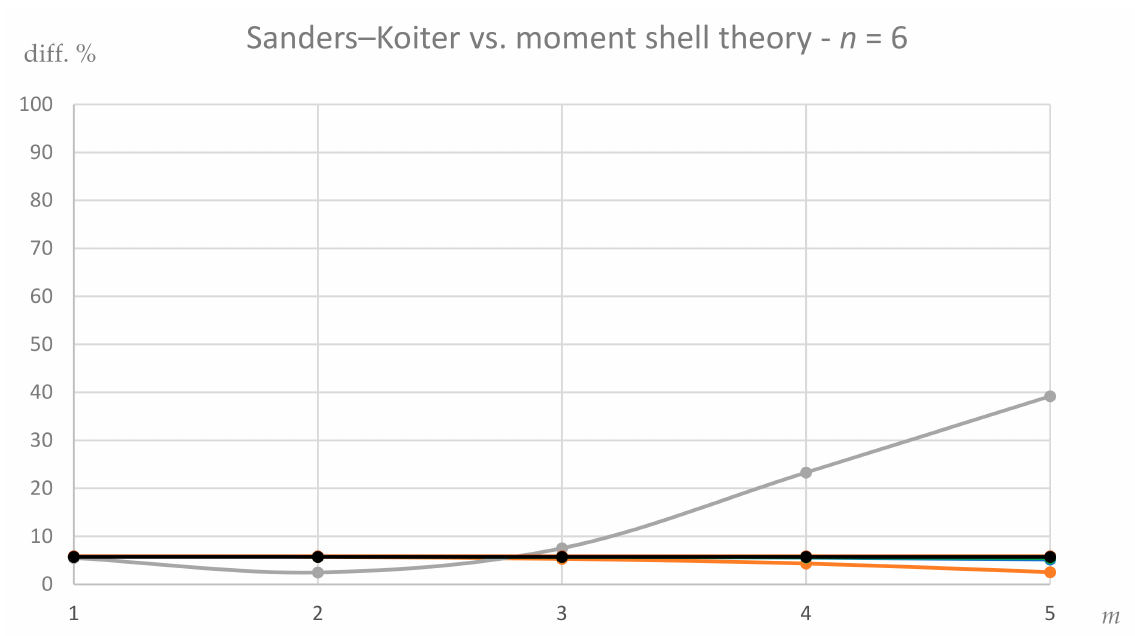
Figure 11. Simply supported DWCNT of Table 1 with different values of aspect ratio L / R 2 and thickness ratio R 2 / h . Shell-like modes ( n = 6). Comparisons between extended Sanders–Koiter and simplified moment shell theories, where L / R 2 = 10, R 2 / h =